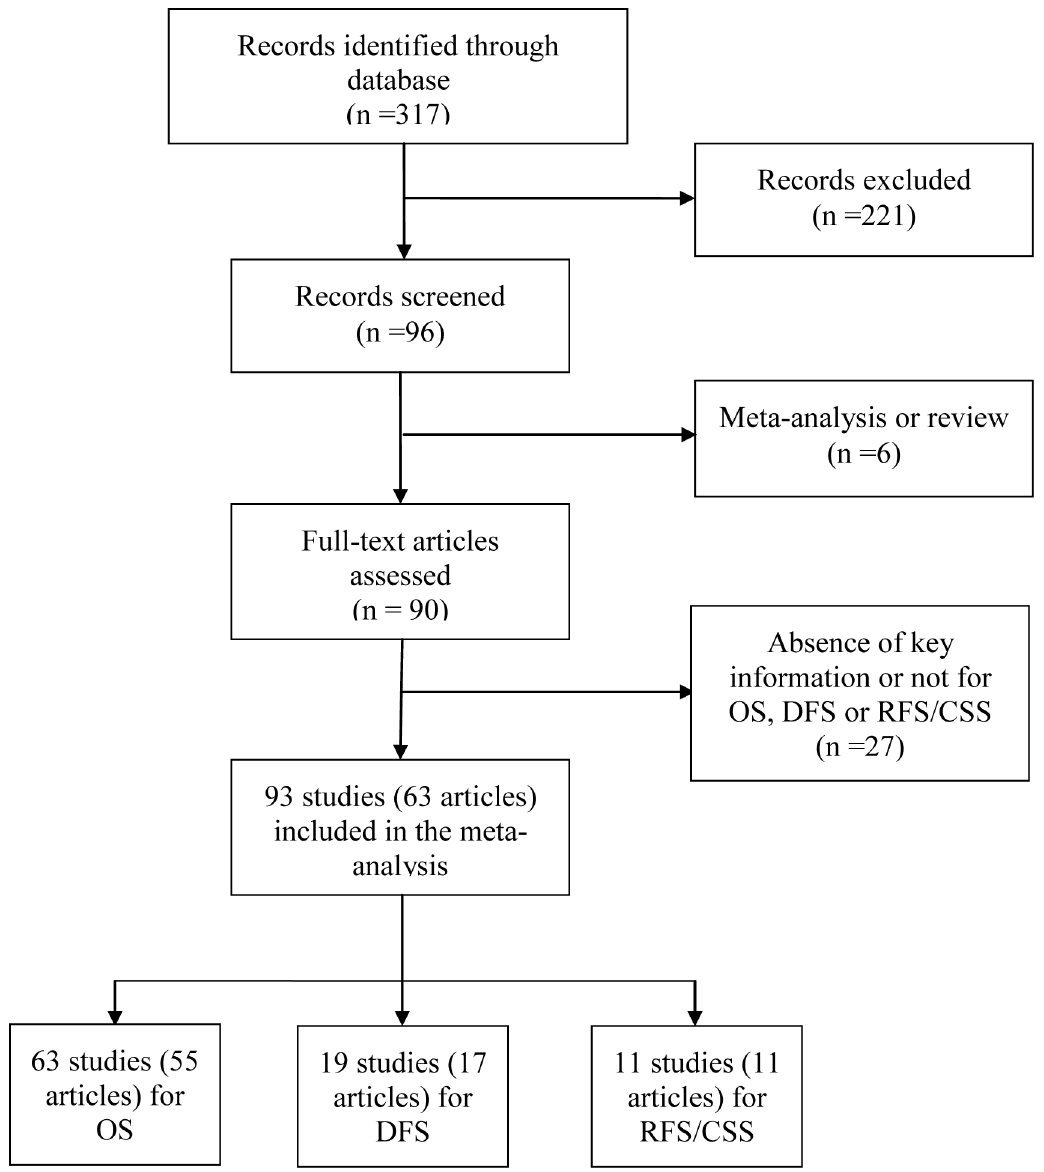
Figure 1. Methodological flow diagram of the review.